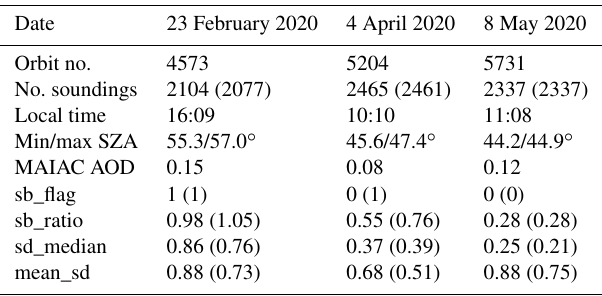
Table 1. Key metadata and statistics for three Australian ECOSTRESS site SAMs chosen for simulation